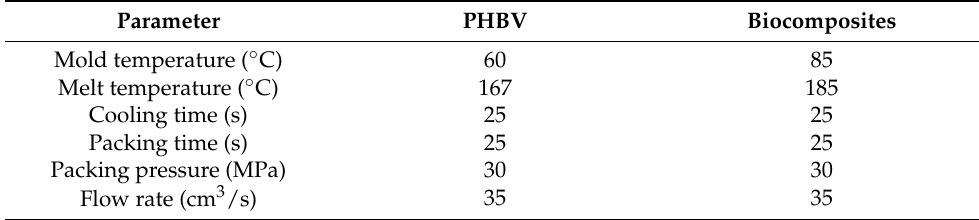
Table 3. The sample processing parameters of the injection molding